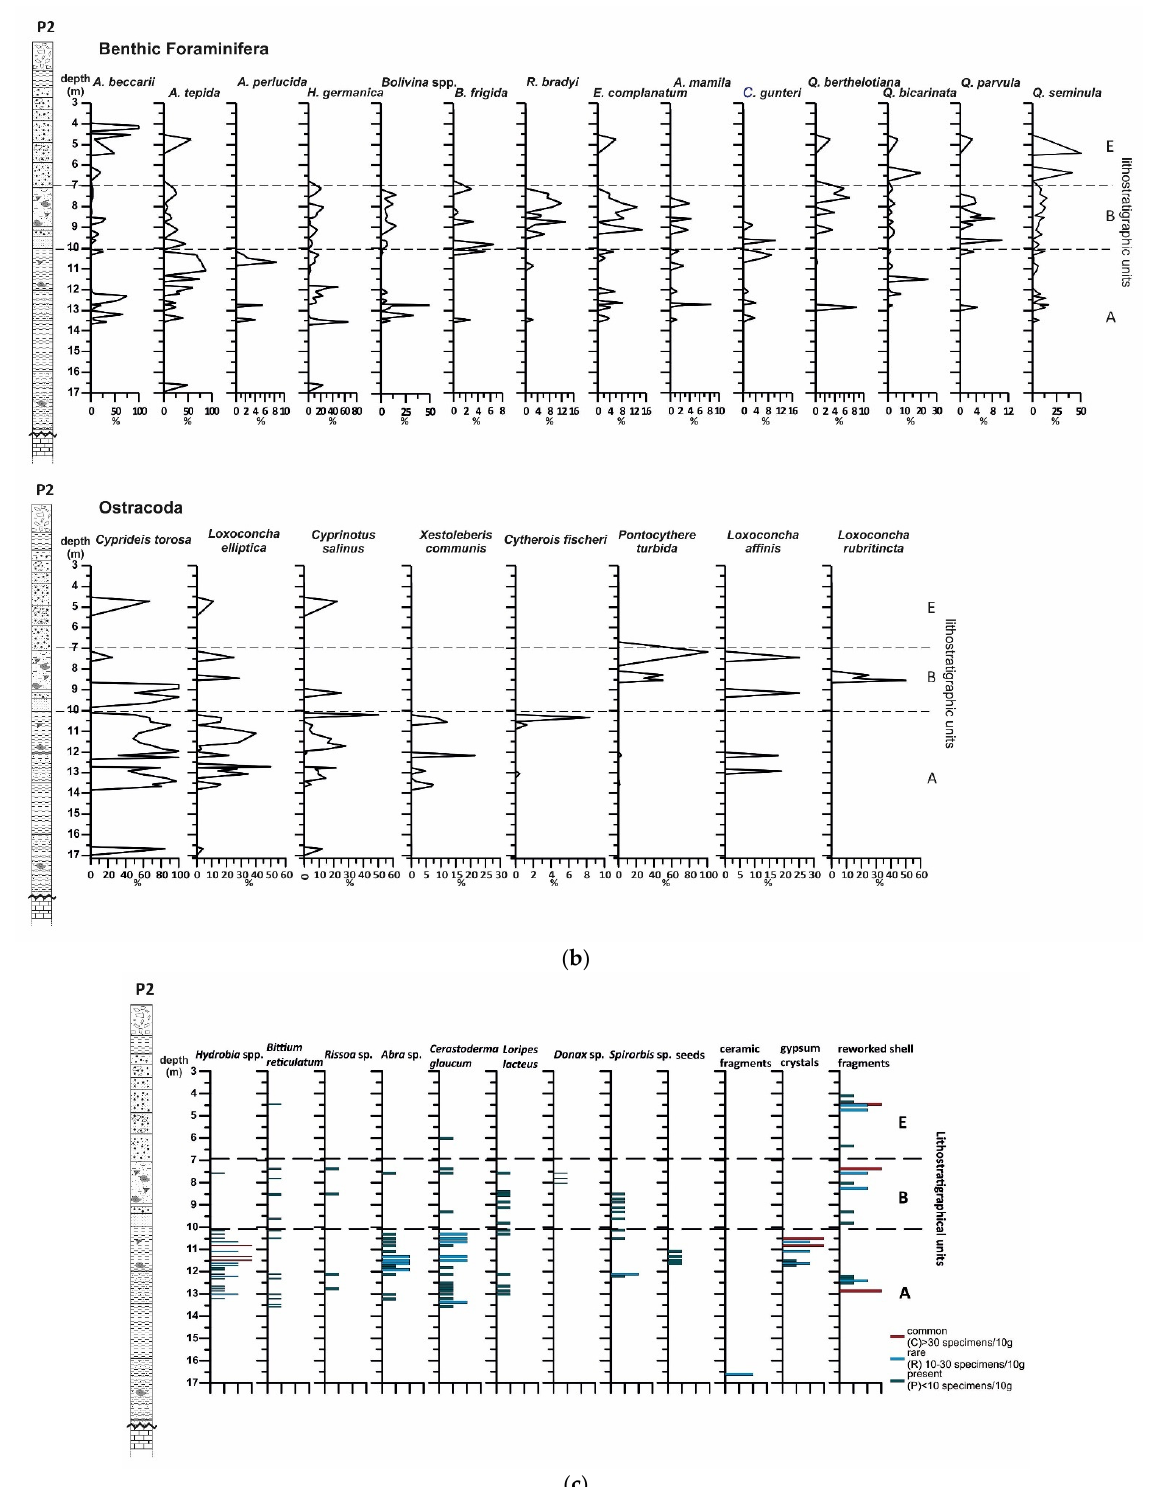
Figure 3. ( a ) Distribution of foraminiferal and ostracod indices along borehole P2 in respect to lithostratigraphic units; ( b ) Relative abundances of the major foraminiferal and ostracod species in borehole P2; ( c ) Distribution and semiquantitative analysis of the main mollusc taxa and other microscopic findings in borehole P2. Lithostratigraphic units (A,B,E) are separated by dotted